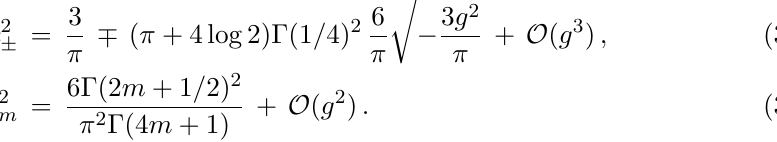
d 2. For (cid:17) (cid:0)